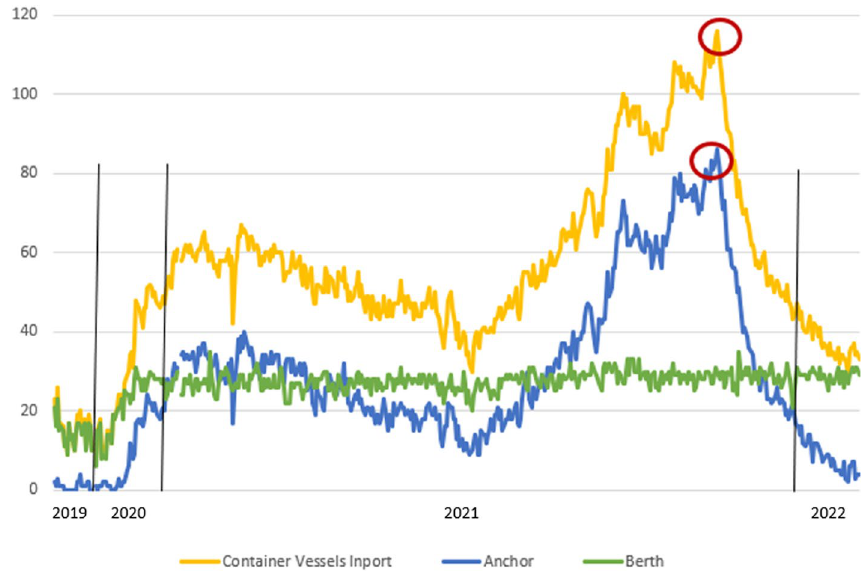
Fig. 6 Total Container Ships inside 25 miles of Los Angeles and Long Beach Jan 1st 2019–Feb 10th